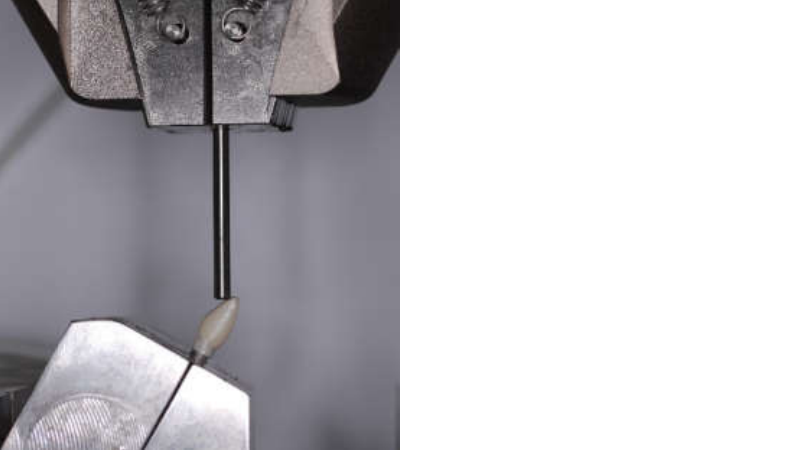
Figure 4. Loading of the assembled specimen with a universal testing machine at 30 ◦